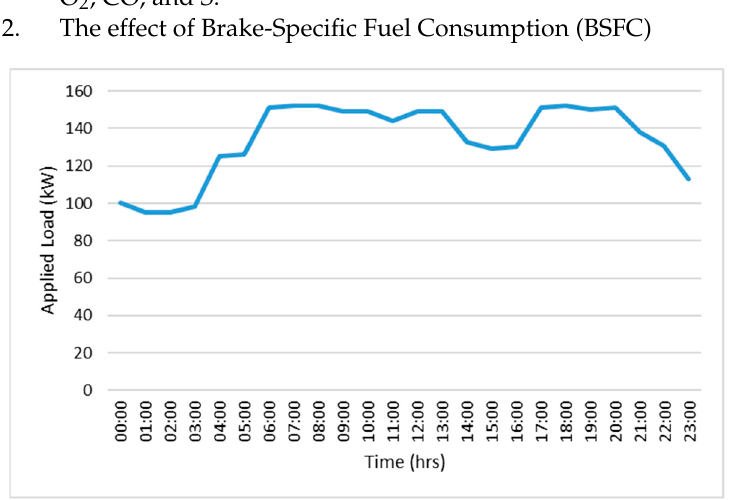
Figure 4. The remote community electrical load pro fi le at Baie-James, Canada.